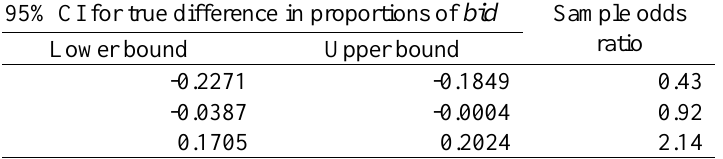
Table 3: Differences in proportions of 'bid' responses and the sample odds ration through paired-group